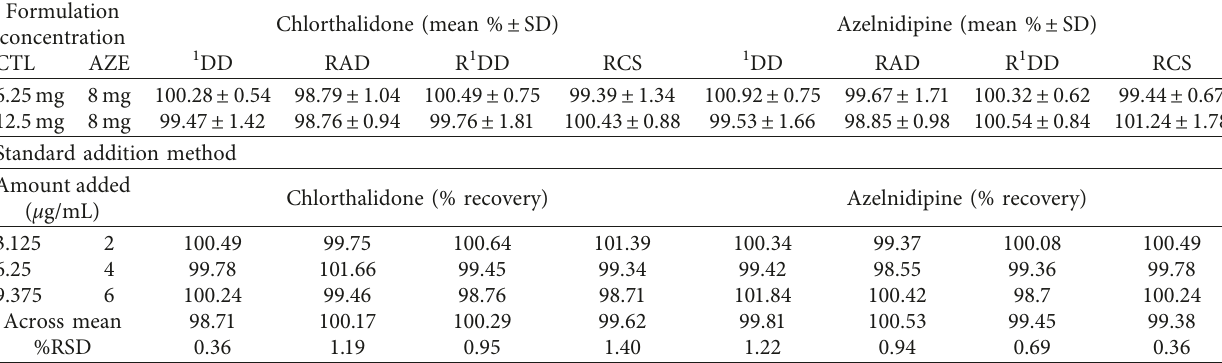
Table 3: Assay results of the formulation and the standard addition method